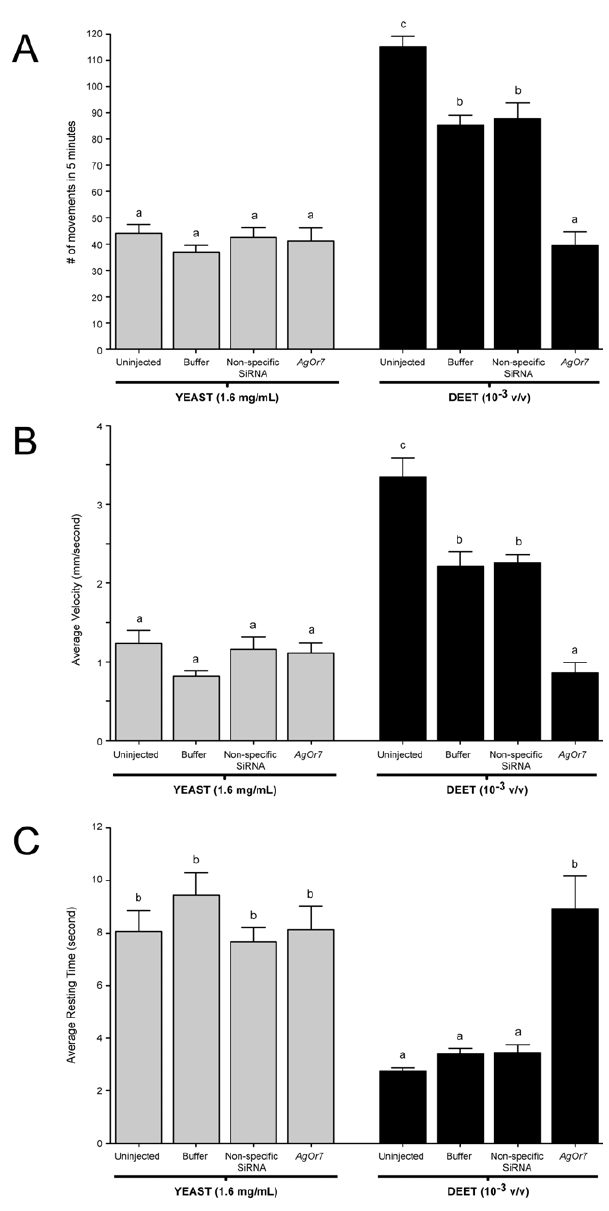
Figure 6. Larval behaviors after injection of non-specific small interfering RNA (siRNA). Averaged responses of buffer, non-specific, and AgOr7 siRNA-injected larvae in the presence of 1.6 mg/ml yeast paste and a 10 2 3 v/v dilution of DEET. Larval movement (A), velocity (B), and resting time (C) behaviors of larvae in response to yeast paste and DEET. Knockdown of AgOr7 mRNA levels has no effect on the ability of larvae to respond to yeast paste yet evokes significant behavioral alterations in larval responses to DEET ( p , 0.01). Results are shown as means 6 SE, n =10. vation of function (Figure 8). Very few strong homologs are observed between AgIRs and DmIRs. Despite their diversity, topology predictions indicate conservation of 4 hydrophobic stretches of amino acids that likely correlate to the transmembrane and pore regions (Figure 9) of known ionotropic glutamate receptors (for review see [22]).